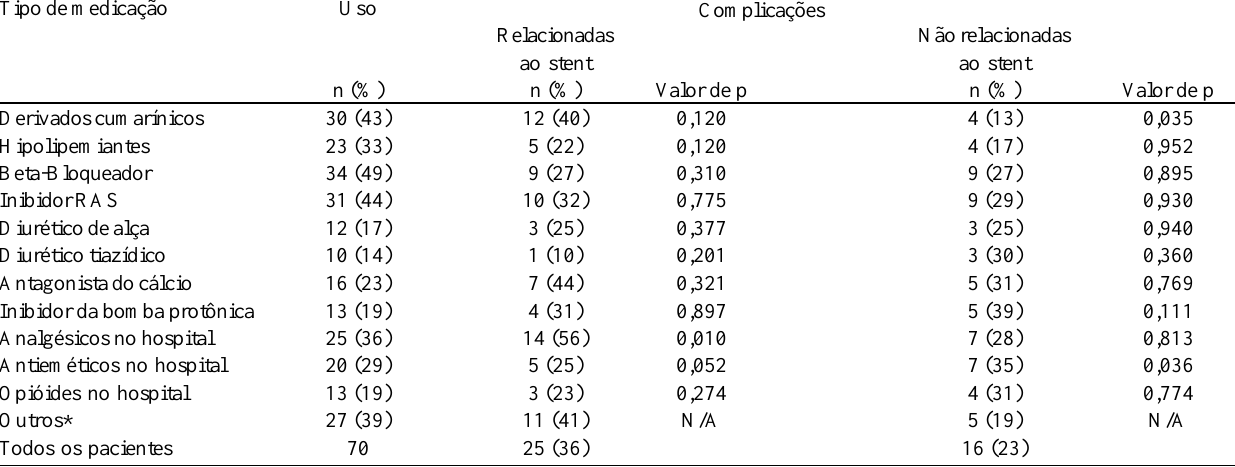
Tabela 3. Medicação e números de